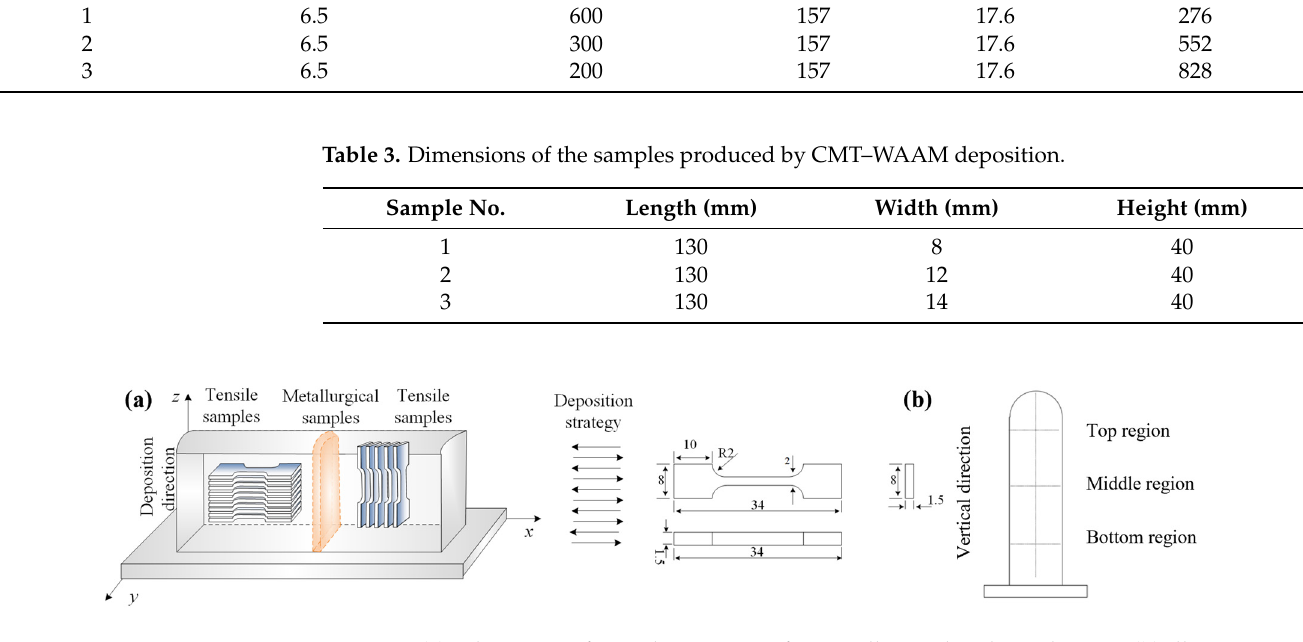
Figure 1. ( a ) Schematics of sample extraction for metallurgical and tensile tests. ( b ) Illustration of micro-hardness testing position.